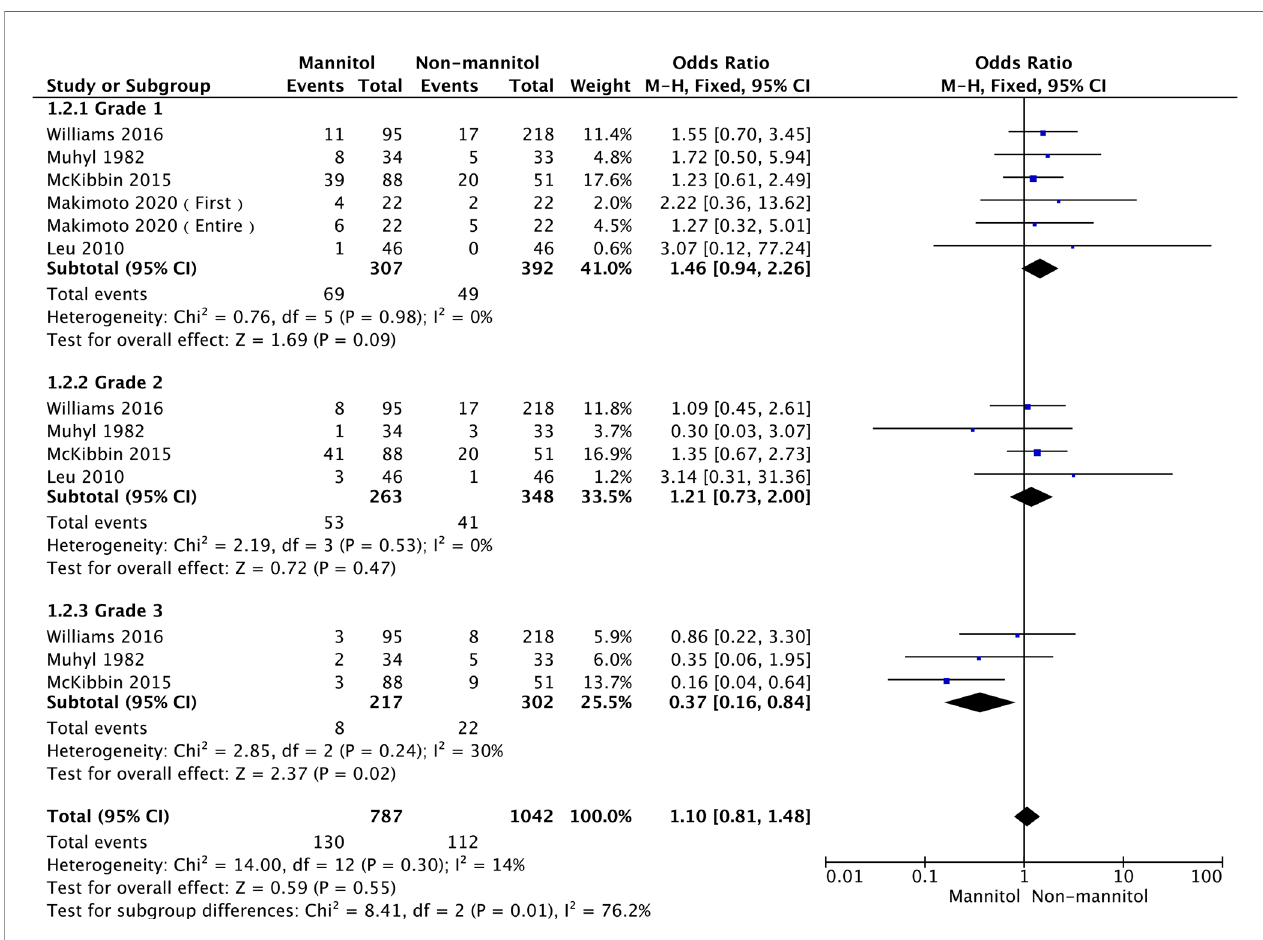
FIGURE 5 | Forest plot of odds ratios (OR) for incidence of cisplatin-induced nephrotoxicity (Grade).